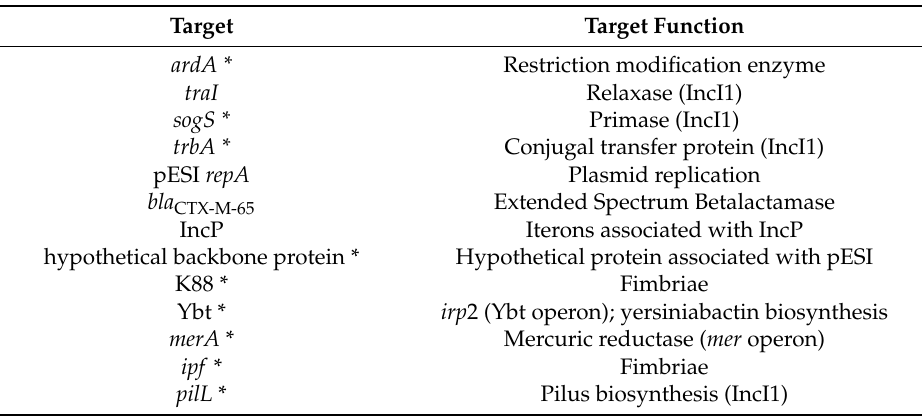
Table 1. Target genes used to determine pESI presence in the carriage